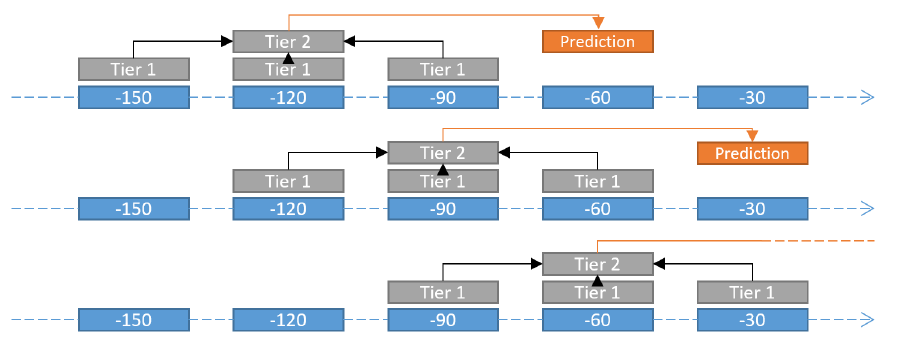
Figure 2. Schematic of the sliding window scheme used by the 2-tiered SVM. (Source: Croonen